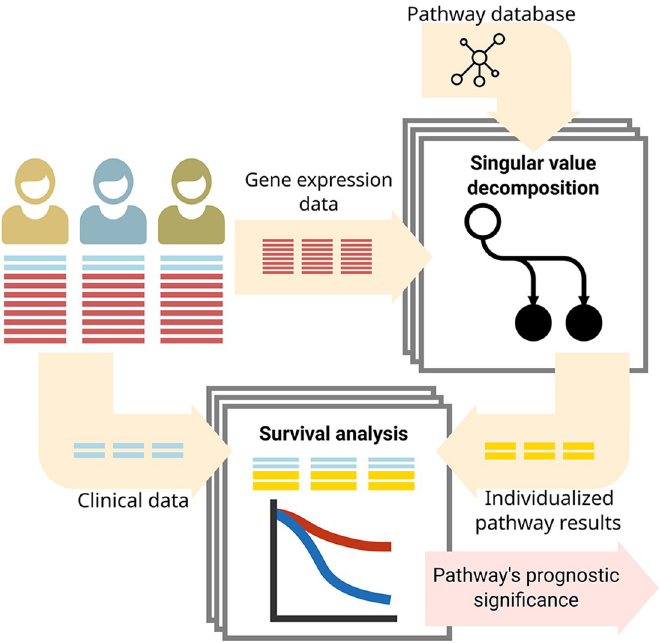
Fig 1. A method to analyze the coupling of pathway activity on patient survival. We used singular value decomposition to give, for each sample and pathway, an individualized pathway readout. We then combine those readouts with the survival information to perform survival analysis on a pathway